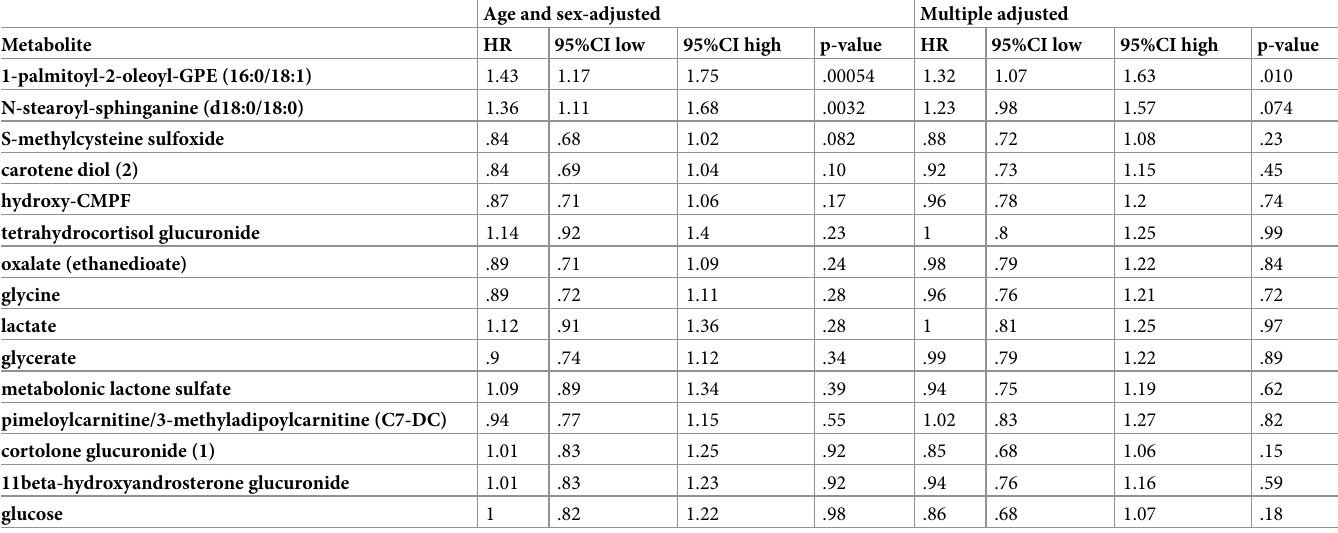
lipids. However, which of these metabolic classes that are involved in the pathogenesis of the clustering of risk factors could not be told from the present study. Table 3. Relationships between the 15 validated metabolites being related to all five components in the metabolic syndrome (MetS) and incident atherosclerotic car- diovascular disease in the EpiHealth cohort. Age and